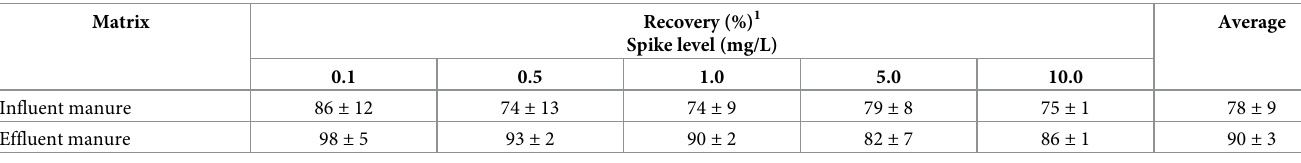
Table 2. Recovery of monensin in dairy